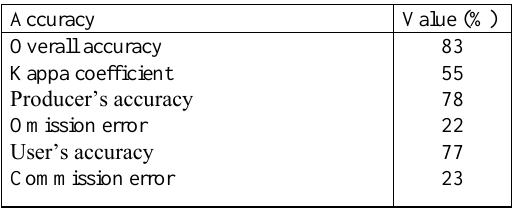
Table 1. The computed